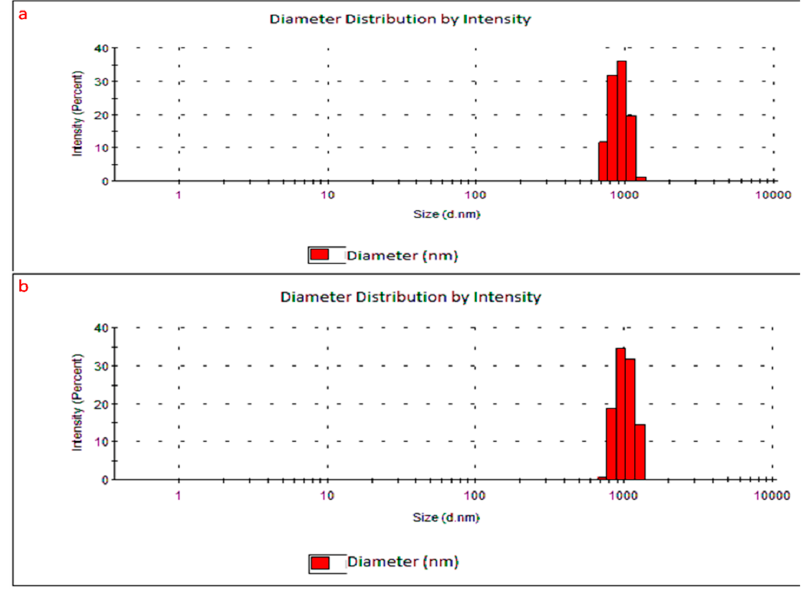
Figure 5. Histograms of the diameter distribution for PC liposomes without encapsulated extract of Stellaria media (L.) Vill. ( a ) and PCE liposomes with encapsulated extract of Stellaria media (L.) Vill. ( b